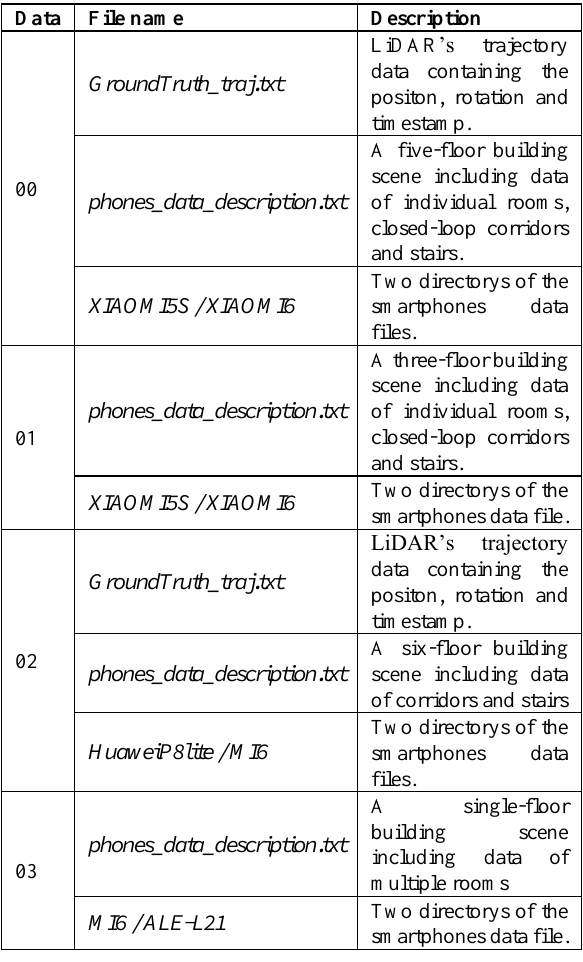
Figure 7. Structure of the indoor positioning dataset. Table 3. Data description of the indoor positioning dataset.